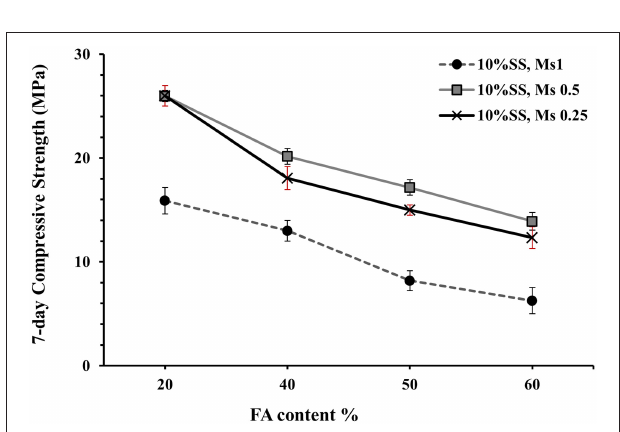
FIGURE 5 | Effect of adding fly ash on 7-day compressive strength for AASF concrete cubes activated by 10 wt.%SS with different alkali modulus values as marked.